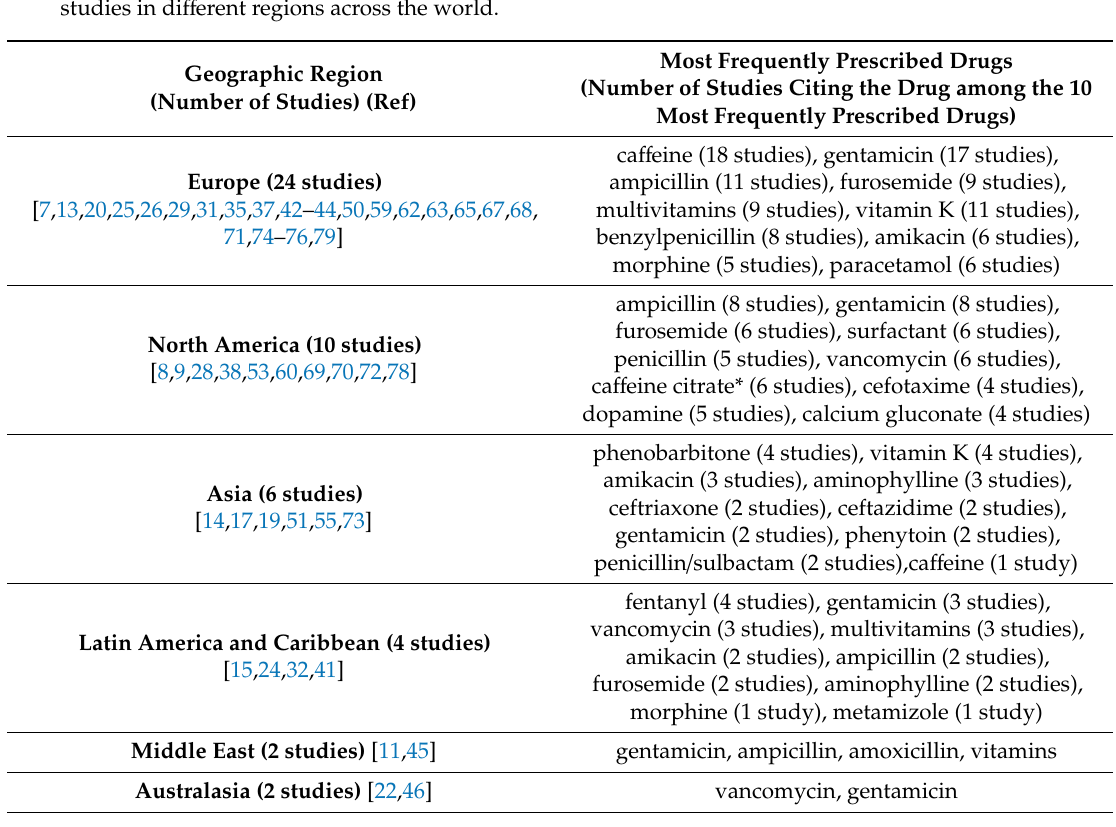
Figure 5. Drugs reported as one of 10 most frequently prescribed in 44 neonatal drug utilization studies. Bars represent the number of studies that reported each drug as one of its 10 most frequently prescribed. Table 1. Drugs reported to be among the 10 most frequently prescribed in neonatal drug utilization studies in di ff erent regions across the